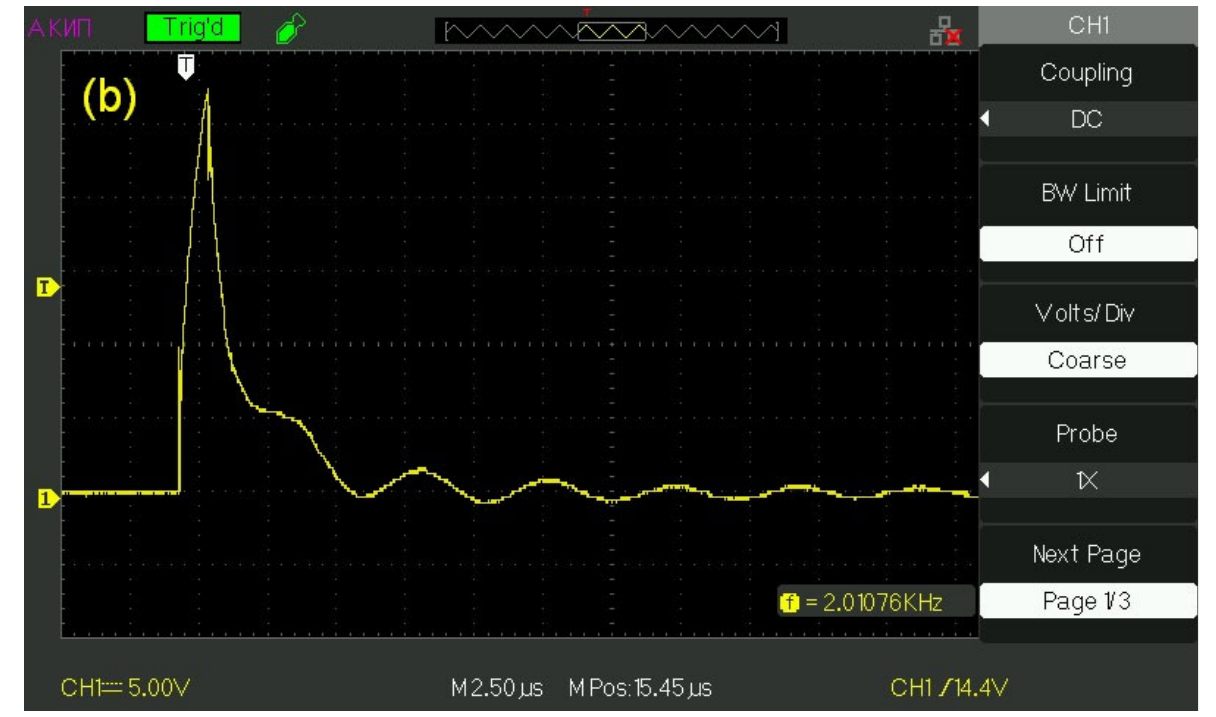
Figure 2. The oscillograms of electrical pulses that were fed to a piezoelectric transducer. Panel ( a )—the transducer is not immersed in water. Panel ( b )—the transducer is immersed in water.